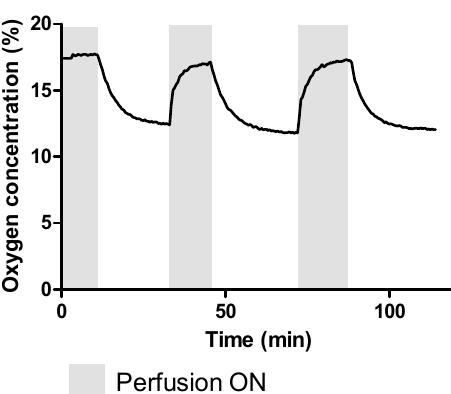
Figure 3. Representative oxygen concentration in the center of a Si-HPMC 2% construct with microchannels seeded with a cell density of 8 million cells / mL and subject to perfusion cycles until recovery of oxygen concentration.